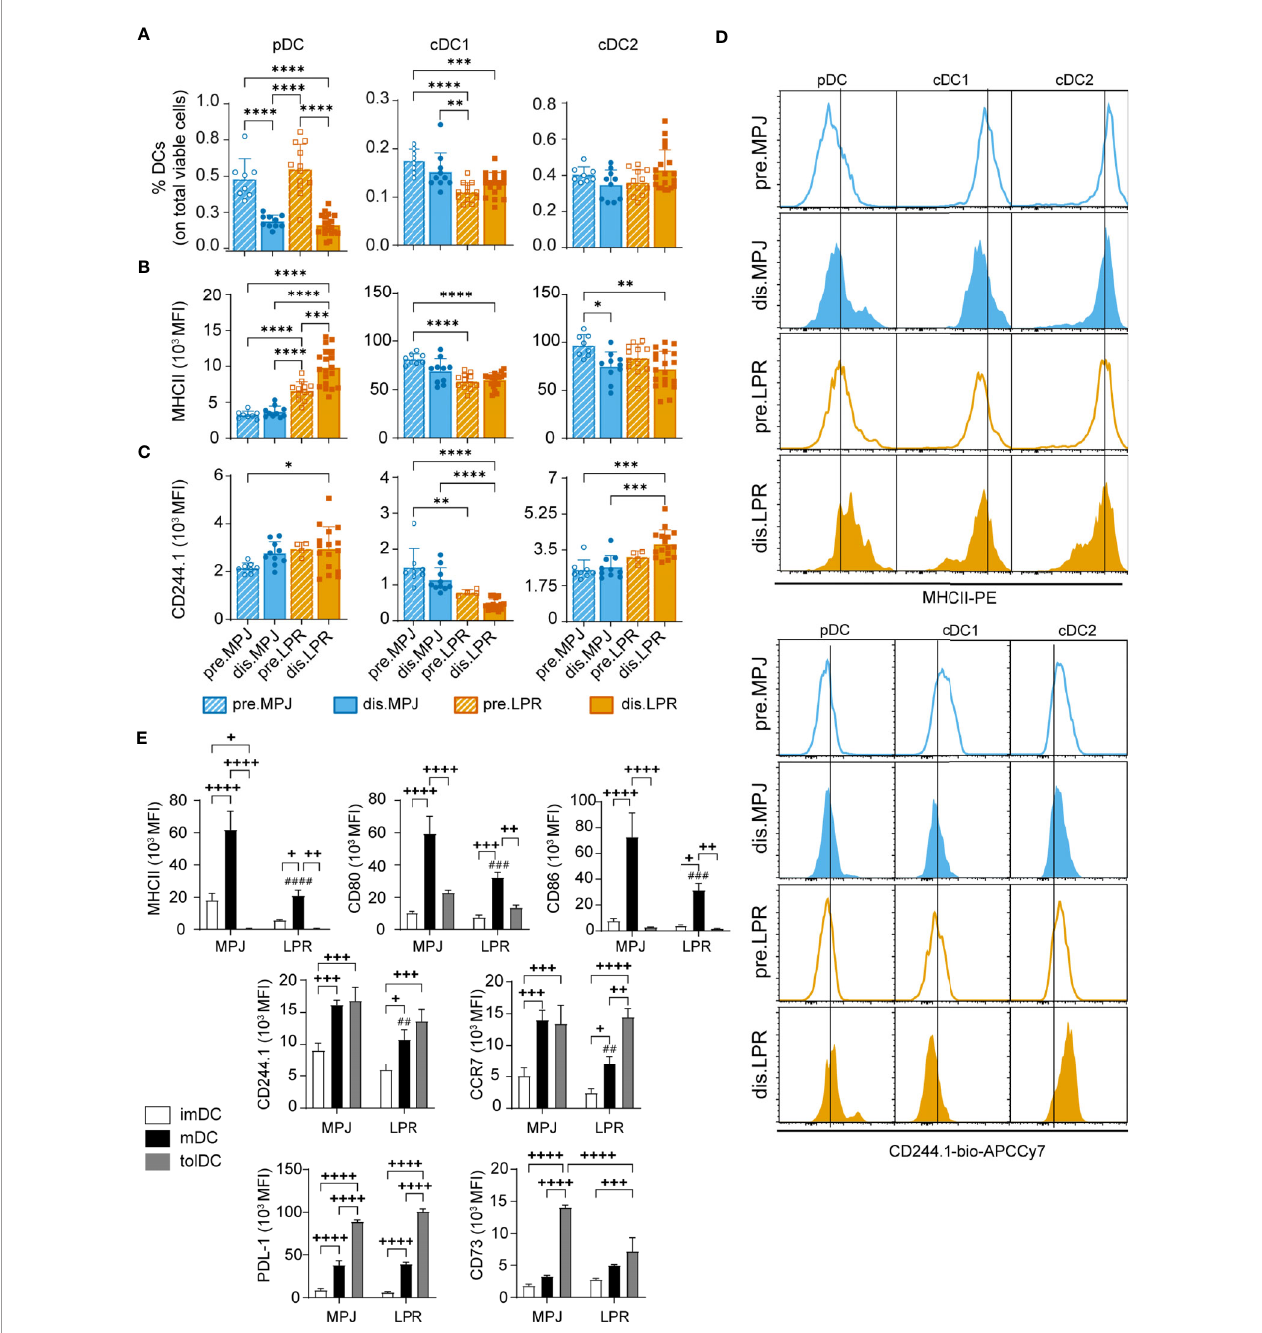
FIGURE 9 | In vitro and in vivo phenotypic analysis of DCs from MPJ and LPR mice. (A) Percentages of splenic plasmacytoid (pDC: CD11c low CD11b - B220 + PDCA-1 + CD3/ CD19 − , left), conventional type 1 (cDC1: CD11c hi CD11b − CD8 a + B220 − PDCA-1 − CD3/CD19 − , middle), and conventional type 2 (cDC2: CD11c hi CD11b + CD8 a − B220 − PDCA- 1 − CD3/CD19 − , right) dendritic cells (DCs) among the total viable cells from MPJ and LPR mice. (B) Quanti fi cation (MFI) of the MHCII expression on pDCs (left), cDC1 (middle), and cDC2 (right). (C) Quanti fi cation (MFI) of the CD244.1 expression on pDCs (left), cDC1 (middle), and cDC2 (right). (D) Representative histograms of (B) (top) and (C) (bottom). The data represent the mean ± SD: *P < 0.05; **P < 0.01; ***P < 0.001; ****P < 0.0001 by one-way ANOVA with a Tukey multi-comparison post-test. Each point represents a single animal: prediseased MPJ (pre.MPJ), n = 8 (A – C) ; diseased MPJ (dis.MPJ), n = 10 (A – C) ; prediseased LPR (pre.LPR), n = 4 – 12 (A – C) ; and diseased LPR (dis.LPR), n = 16 (A – C) . (E) Quanti fi cation (MFI) of different DC markers on immature (imDC), mature (mDC), and tolerogenic (tolDC) DCs from the bone marrow of MPJ and LPR mice. The data represent the mean ± SD: + P < 0.05, ++ P < 0.01, +++ P < 0.001, and ++++ P < 0.0001 for comparisons between imDCs, mDCs, and tolDCs from MPJ or LPR animals; and ## P < 0.01, ### P < 0.001, and #### P < 0.0001 for the comparisons between mDCs from MPJ and LPR animals, using a two-way ANOVA with a Tukey multi-comparison